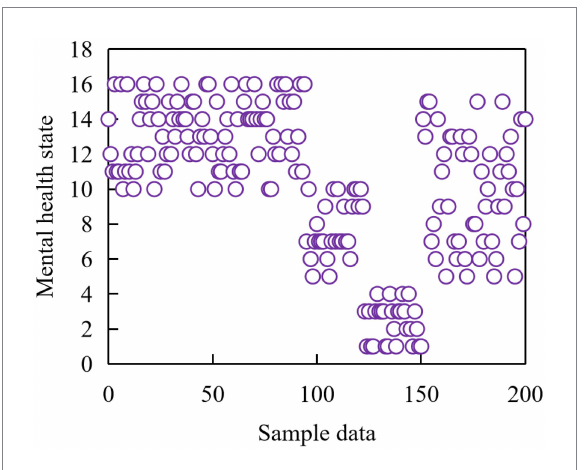
FIGURE 8 Cluster analysis chart of students’ mental health status.